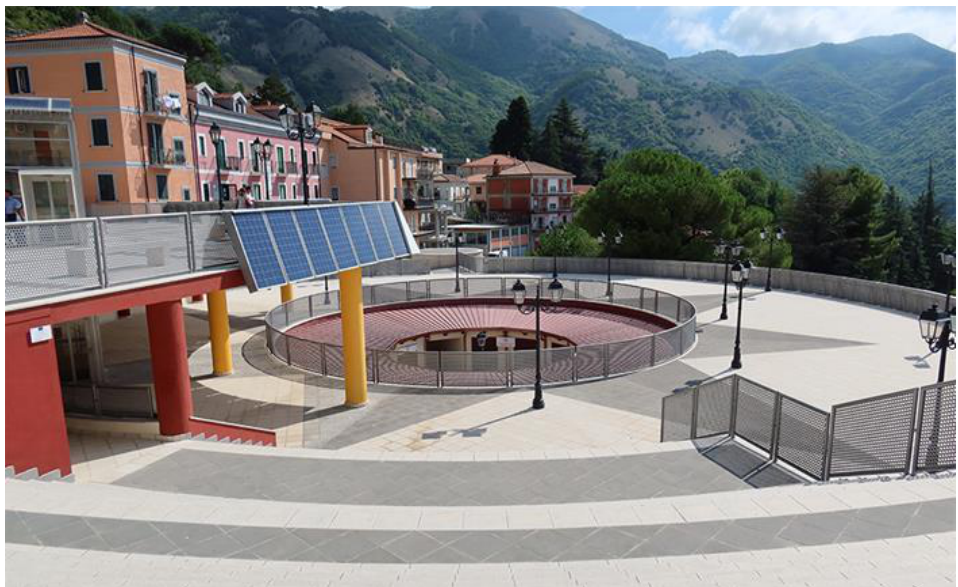
Figure 83. Colliano: New Epifani Square (photos by [35,36]).